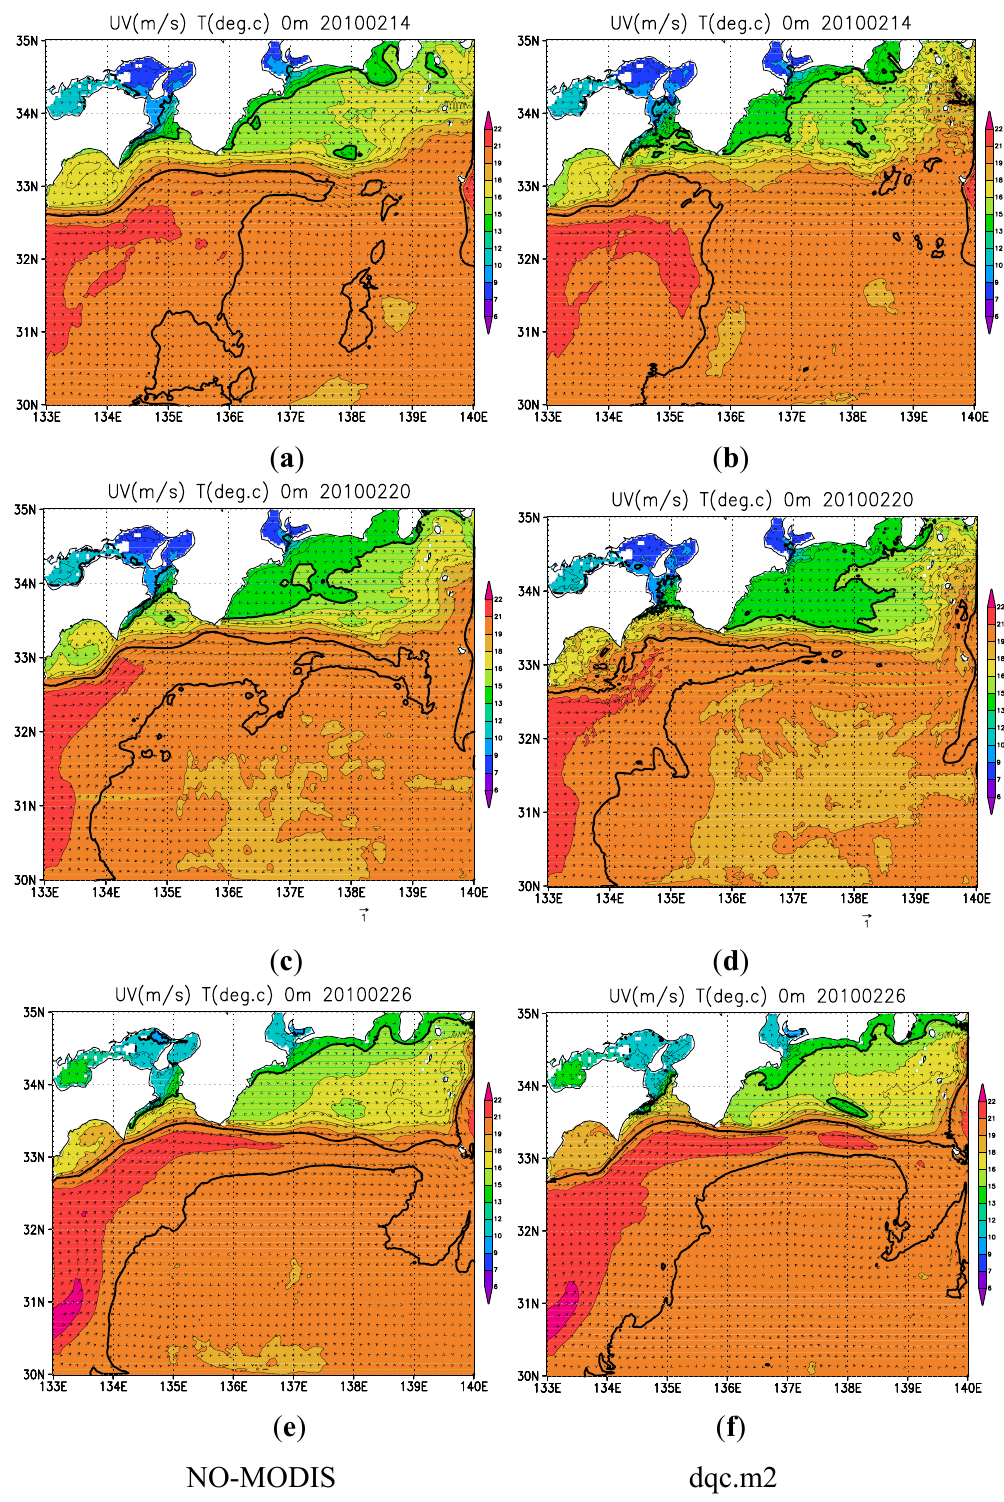
Figure 4. Snapshots of ensemble mean sea surface temperature (shade and contours) and flows (vectors). Interval of thin (thick) contours is 1 ° C (5 ° C). ( Left ): NO-MODIS. ( Right ): dqc.m2. ( a , b ): 14 February 2010. ( c , d ): 20 February 2010. ( e , f ): 26 February